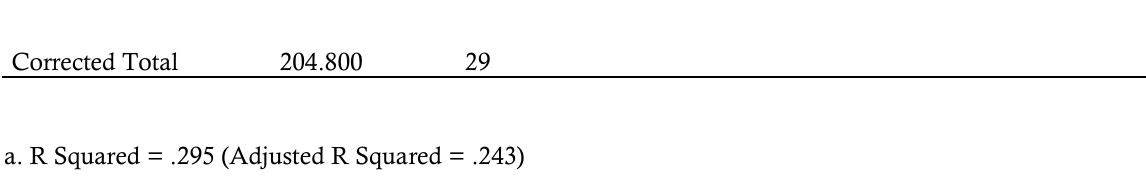
Table 4: ANCOVA on Mean Anxiety Scores between Aged People Exposed to Counselling and those that are not Type III Sum of Source Squares df Mean Square F Sig. Corrected Model 200.642 a 2 100.321 7.278 .003 .350 Intercept 265.574 Group 191.972 191.972 Error 372.158 27 13.784 Total 3454.000 30 Corrected Total 572.800